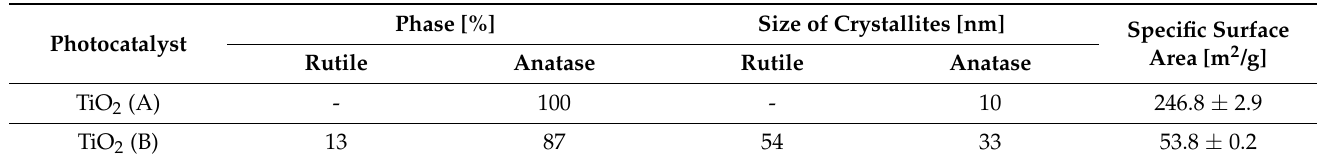
Table 1. The content of crystalline phases and the size of crystallites (measured via XRD), and specific surface area (measured via BET).